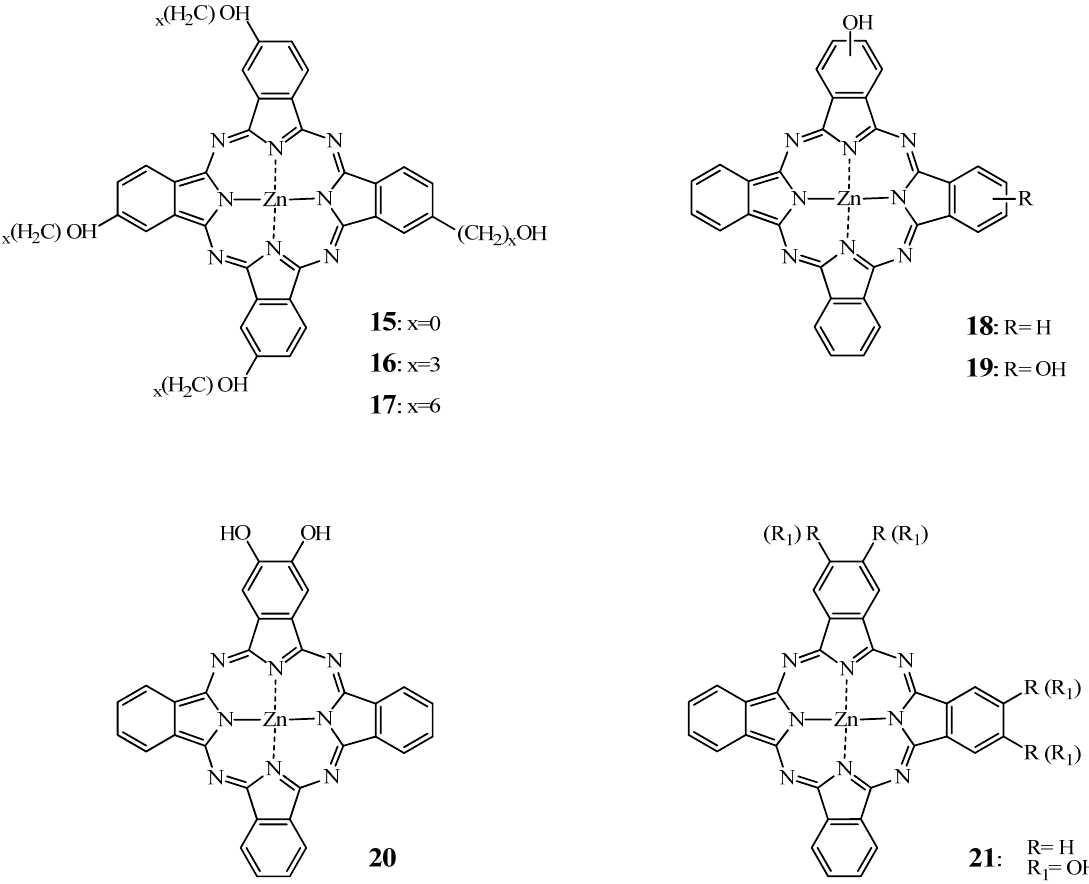
Figure 8. Chemical structure of hydroxylated phthalocyanines 15–21